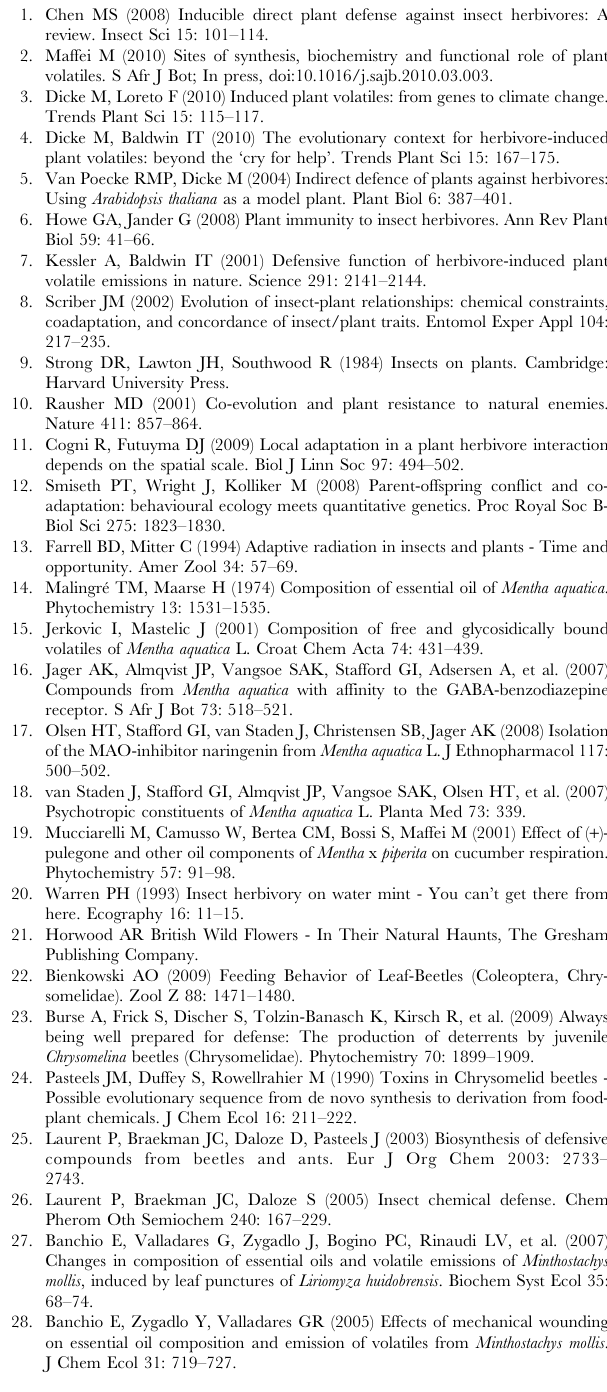
Figure S4 M. aquatica plants observed in the wild. The upper left panel shows an undamaged M. aquatica in full bloom. The upper right panel shows male and female C. herbacea mating on partially damaged M. aquatica leaves. The two lower panels show the typical level of damage inferred by C. herbacea on wild M. aquatica